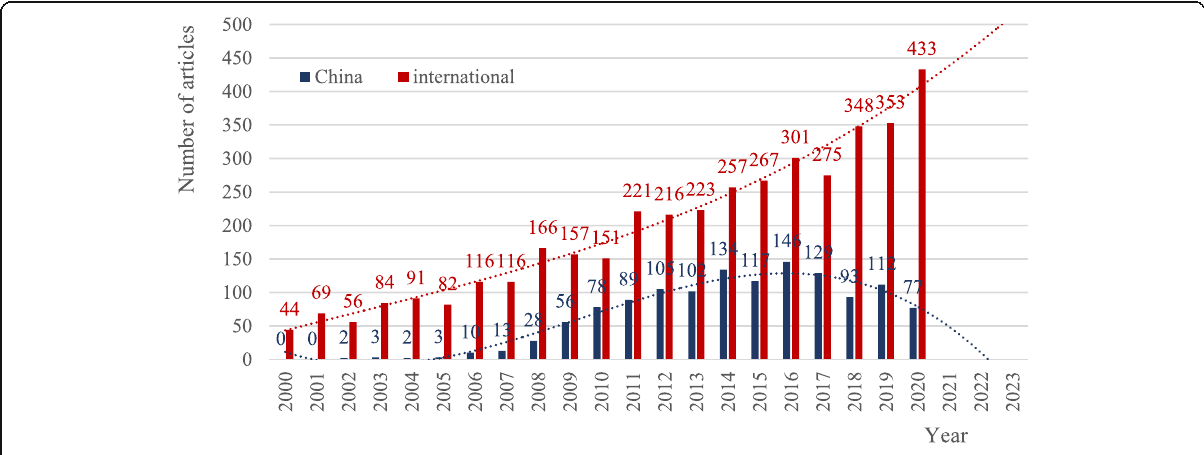
Fig. 1 Temporal distribution of international and Chinese risk communication